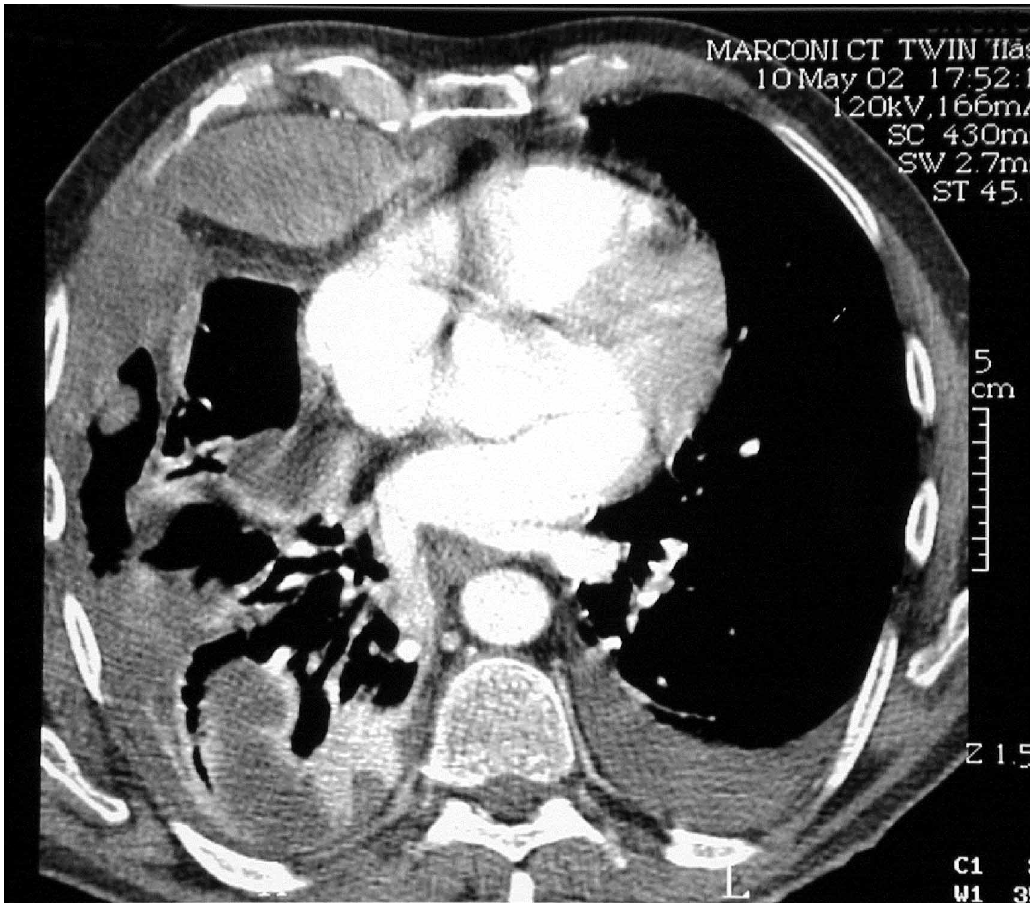
Fig. 1. Thoracic CT-scan showing the bilateral